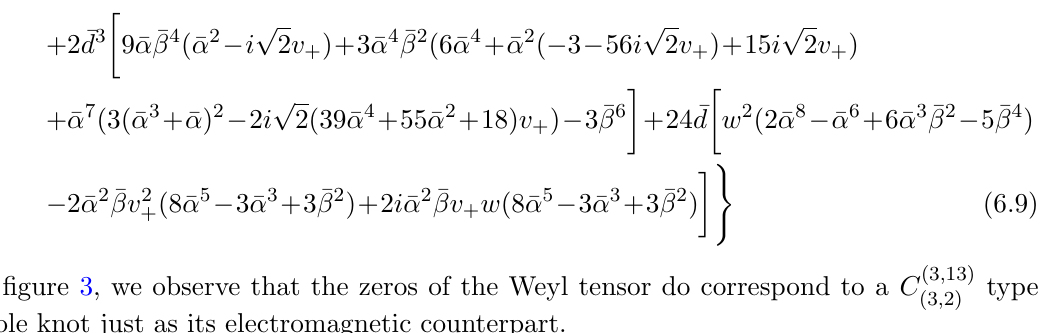
Figure 1 . The zeros of the Maxwell (top, in black) and Weyl (bottom, in blue) spinor obtained by the intersections of the real and imaginary parts of complex (cid:31) (in blue) and M (in orange) for ( m = 2 ; n = 2). Plots are shown at t = 0 and t = 1